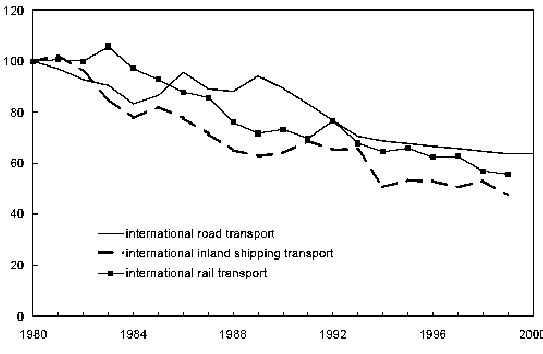
Fig 4. Real price indices in the Netherlands, per tonne-km